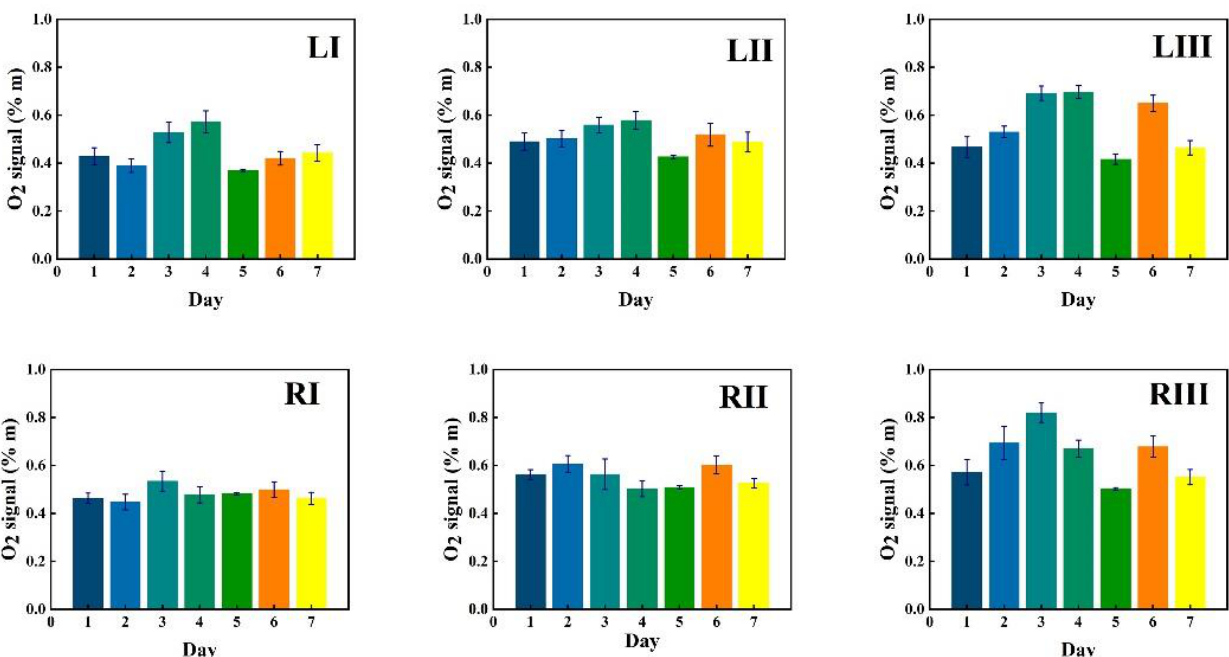
Figure 5. The changes of measured oxygen signal at different locations (according to Figure 2) for volunteer 1 during one week, together with the standard deviation.